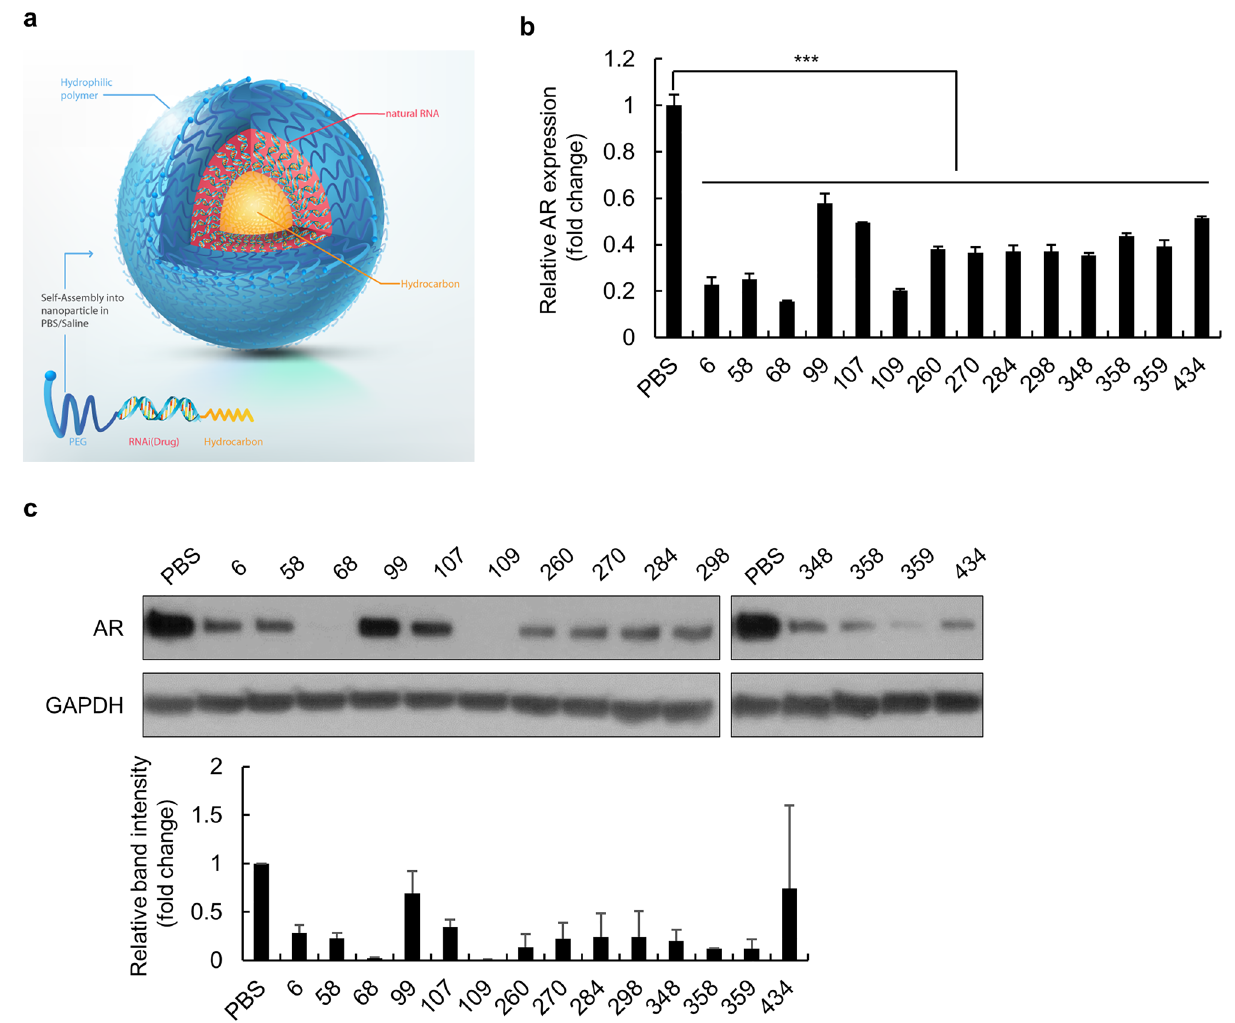
Figure 1. Screening of potent SAMiRNAs targeting human AR. ( a ) Schematic of SAMiRNA nanoparticles. ( b , c ) LNCaP cells were treated with PBS or 14 SAMiRNA candidates for 48 h. Total RNA extracts were subjected to quantitative polymerase chain reaction (qPCR) assays to evaluate AR knockdown efficacy, and AR expression was normalized to the expression of the ribosomal protein lateral stalk subunit P0 (RPLP0) gene ( b ). Whole-cell lysates were subjected to immunoblot analysis to compare the protein levels of AR and GAPDH. The intensity of the AR and GAPDH bands was quantified by ImageJ software, and AR protein expression was normalized to glyceraldehyde-3-phosphate dehydrogenase (GAPDH) values ( c , lower panel). Statistical significance was assessed by two-sided Student’s t test, *** p <